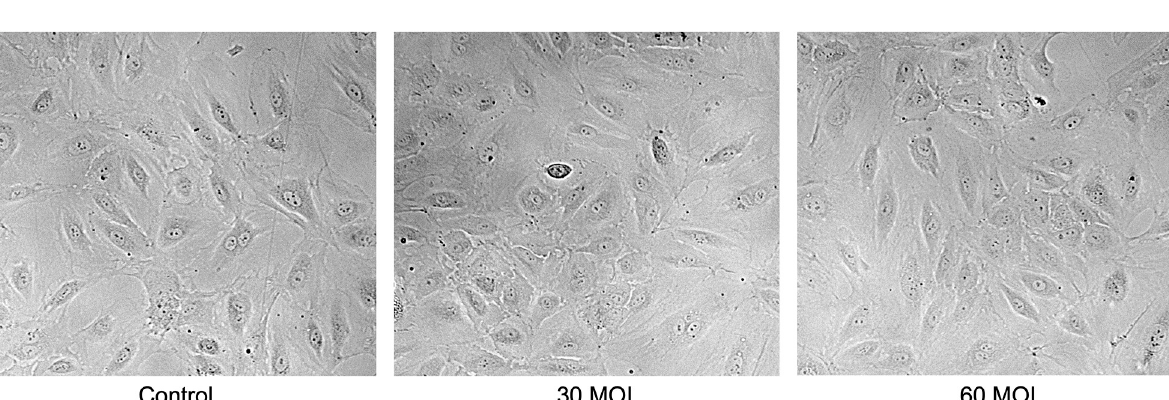
PLOS ONE | https://doi.org/10.1371/journal.pone.0276232 October 19,